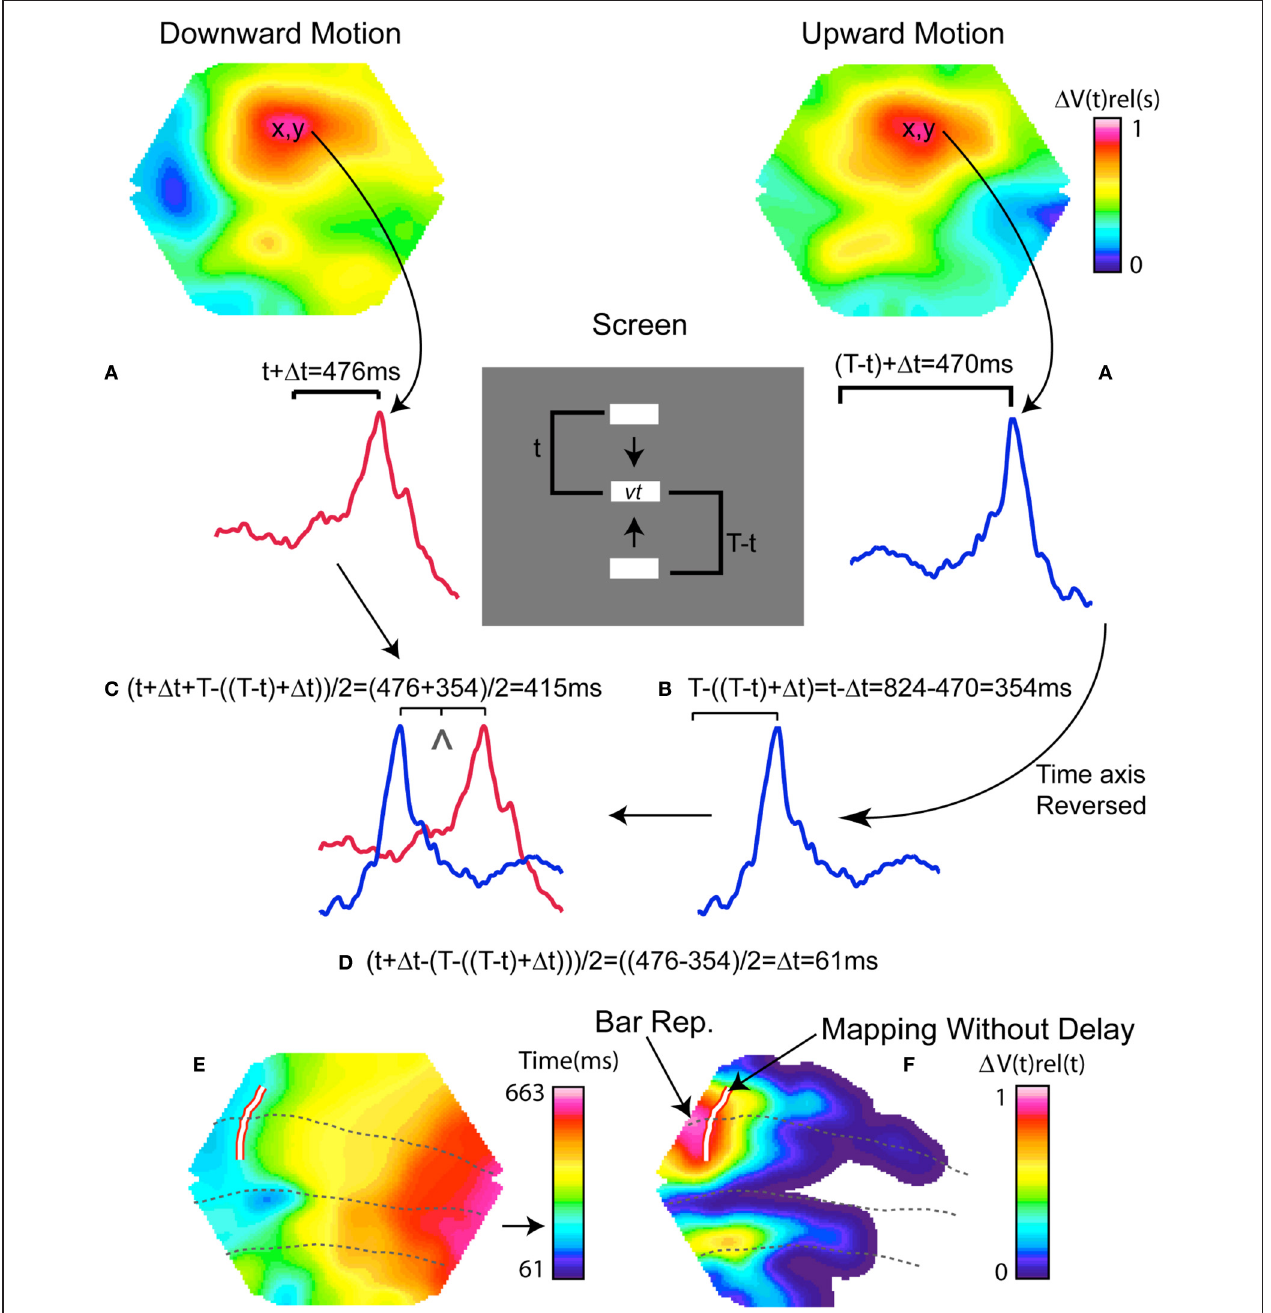
FIGURE A1 | Mapping of the mean maximum (cid:2) V ( t ) without delay: in order to get an estimate of the position of the object representation on the cortex at any given time, we used the strategy of Kalatsky and Stryker (2003). Briefly, the contrast bar moves with a velocity v over the screen, starting at 0ms at the top/bottom of the screen and ending at T ms at the bottom/top of the screen, here T = 824ms. After a certain time, t , the bar position on the screen, vt , is mapped to a cortical position ( x, y ). The (cid:3) V ( t ) at position ( x , y ) reaches its maximum after a certain delay, (cid:3) t , after the bar has arrived at screen